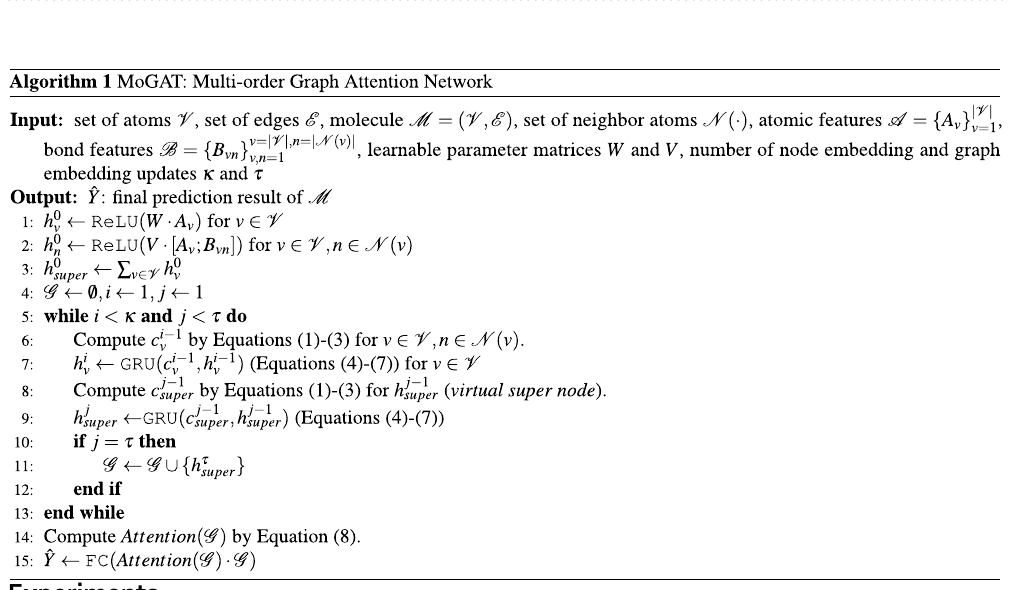
Table 1. Search ranges for hyperparameters of MoGAT. The optimal values are highlighted in boldface. κ and τ denote the number of node embedding and graph embedding updates, respectively. In addition, d G denotes dimension of the